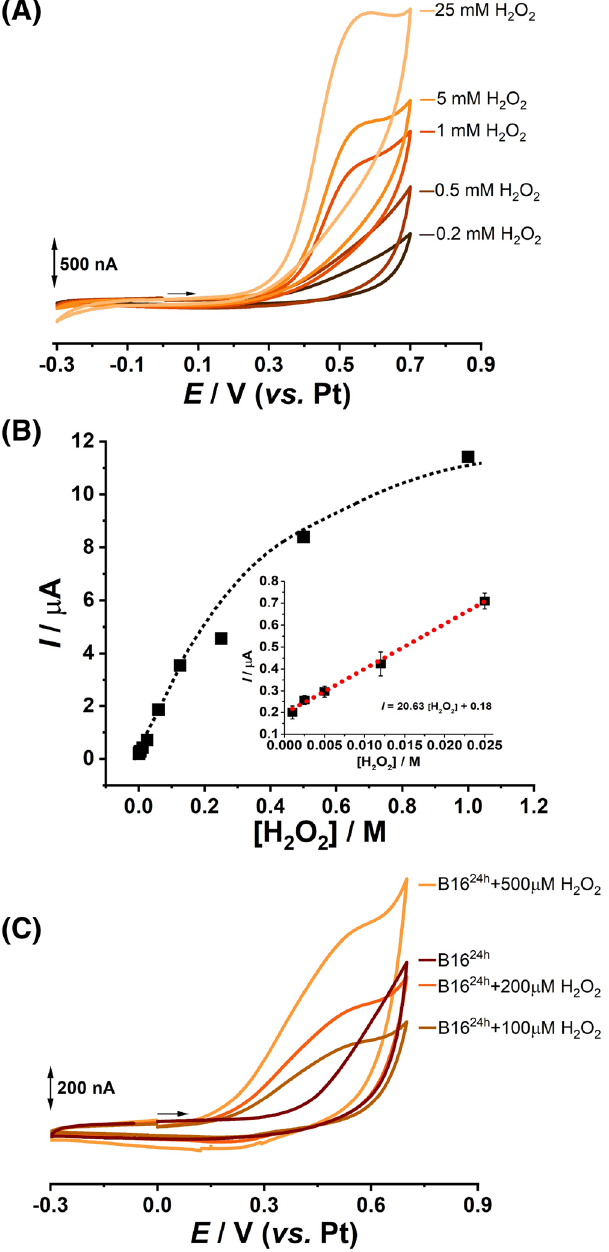
Figure 5. Cyclic voltammograms results recorded at gold working electrodes after 30 min incubation with different concentrations of H 2 O 2 for ( A ) culture medium with the corresponding ( B ) plot of oxidation current vs . H 2 O 2 concentration and ( C ) B16 cells grown at the electrode